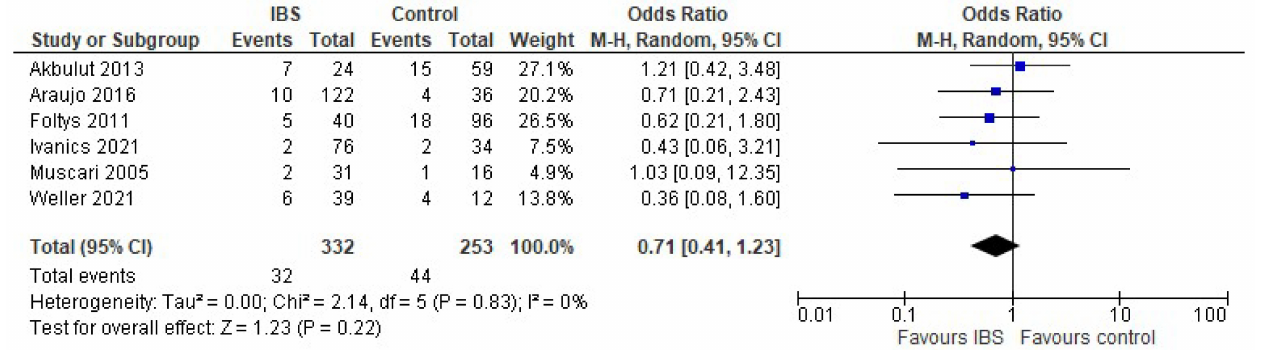
Figure 3. Forest plot for recurrence in liver transplant patients with IBS and without. Blue squares indicate individual effects and black diamond illustrates overall effect.